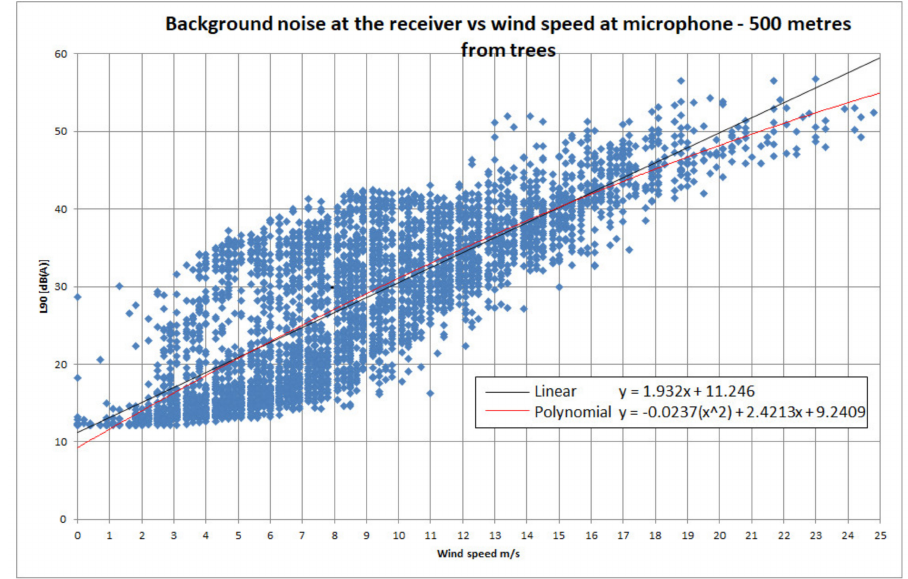
Figure 5. Synchronized background noise level versus wind speed at microphone for measurement location 500 metres from